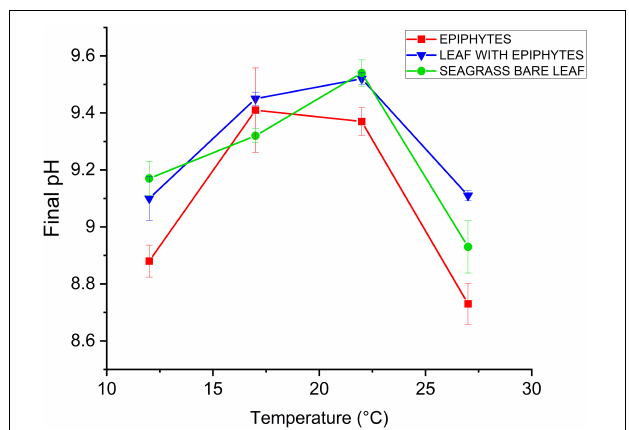
FIGURE 4 | Inorganic carbon extraction capacity as a function of increasing temperature (12, 17, 22, and 27 ◦ C). Red symbols and lines represent epiphytes originating from Z. marina leaves. Blue symbols and lines represent Z. marina leaves with epiphytes. Green symbols and lines represent bare Z. marina leaves. Data point with error bars represent means ± SEM ( n = 4, biological